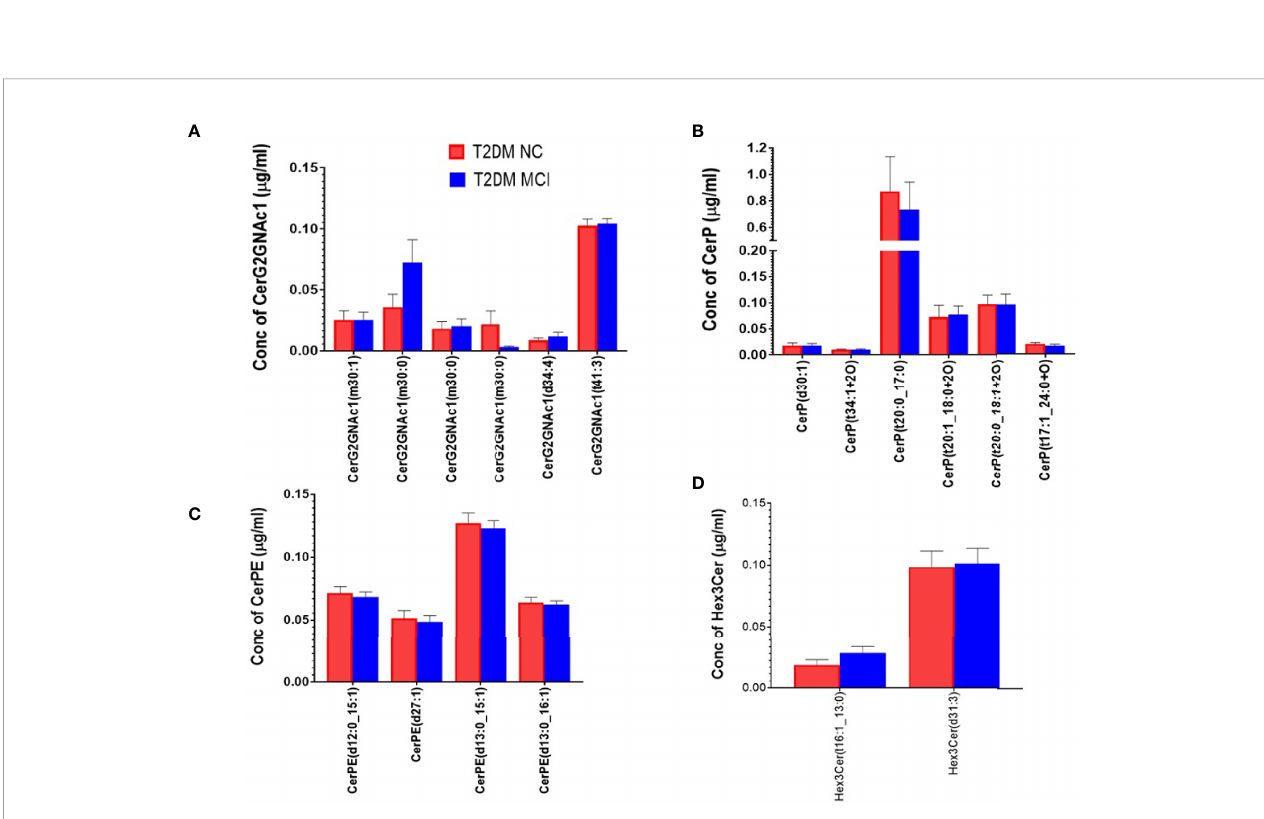
FIGURE 4 | A detailed evaluation of the concentrations of individual species of CerG2GNAc1 species, ceramide phosphates (CerP) and phosphorylethanolamine ceramides (CerPE) and trihexosyl ceramides (Hex 3 Cer) in the serum of MCI and NC group of T2DM patients. Evaluation of 6 species of CerG2GNAc1 (A) , 6 species of CerP (B) , 4 species of CerPE (C) , and 2 species of Hex 3 Cer (D) showed no signi fi cant difference between the two groups.